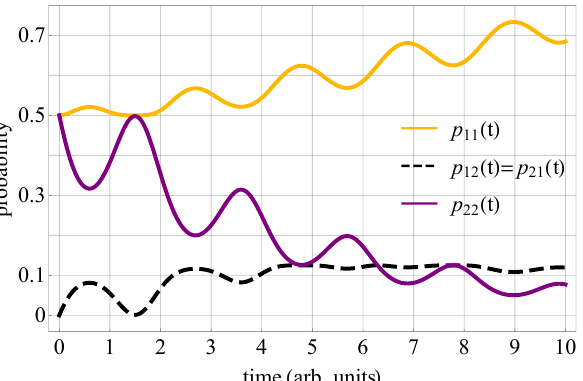
Figure 14. Concurrence, C [ ρ AB ( t )] , for three values of ω and the initial state: ρ AB ( 0 ) = The backflow of information caused by non-Markovianity can also be observed by studying the probabilities corresponding to finding the system (upon measurement) in an admissible state. In Figure 15, we present plots for a selected value of ω . In particular, the first backflow is evident, when the probabilities return to their initial values, and the entanglement is regained. Later on, the probabilities oscillate.